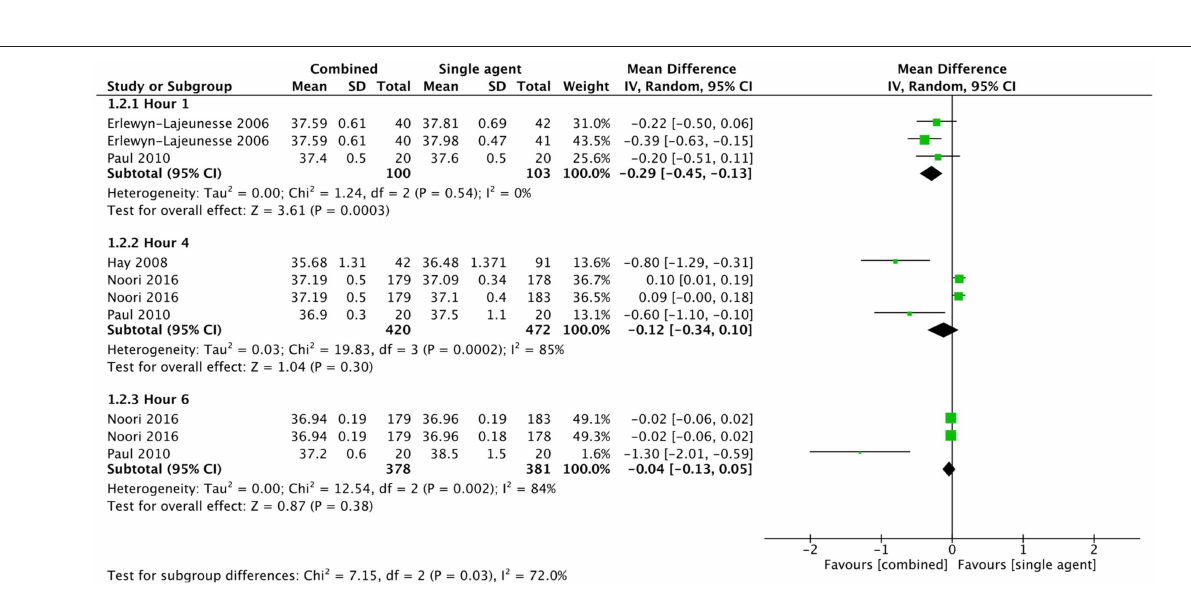
FIGURE 5 | Comparison: combined vs. single agent, Outcome: mean